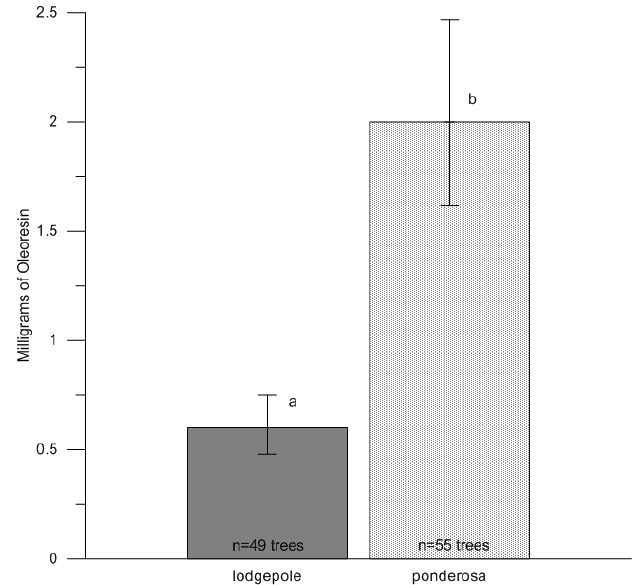
Figure 1. Total preformed quantitative oleoresin (mean milligrams oleoresin ± 1/2 least significant differences (LSDs)) from lodgepole pine ( P. contorta var. latifolia ) and ponderosa pines ( P. ponderosa ) in the Colorado Front Range 24 h after wounding. Differing letters indicate significance p < 0.05 determined from an analysis of variance (ANOVA) (Proc GLM; SAS). Means ±1/2 LSDs. Error bars are ±half approximate LSD; n = 104.